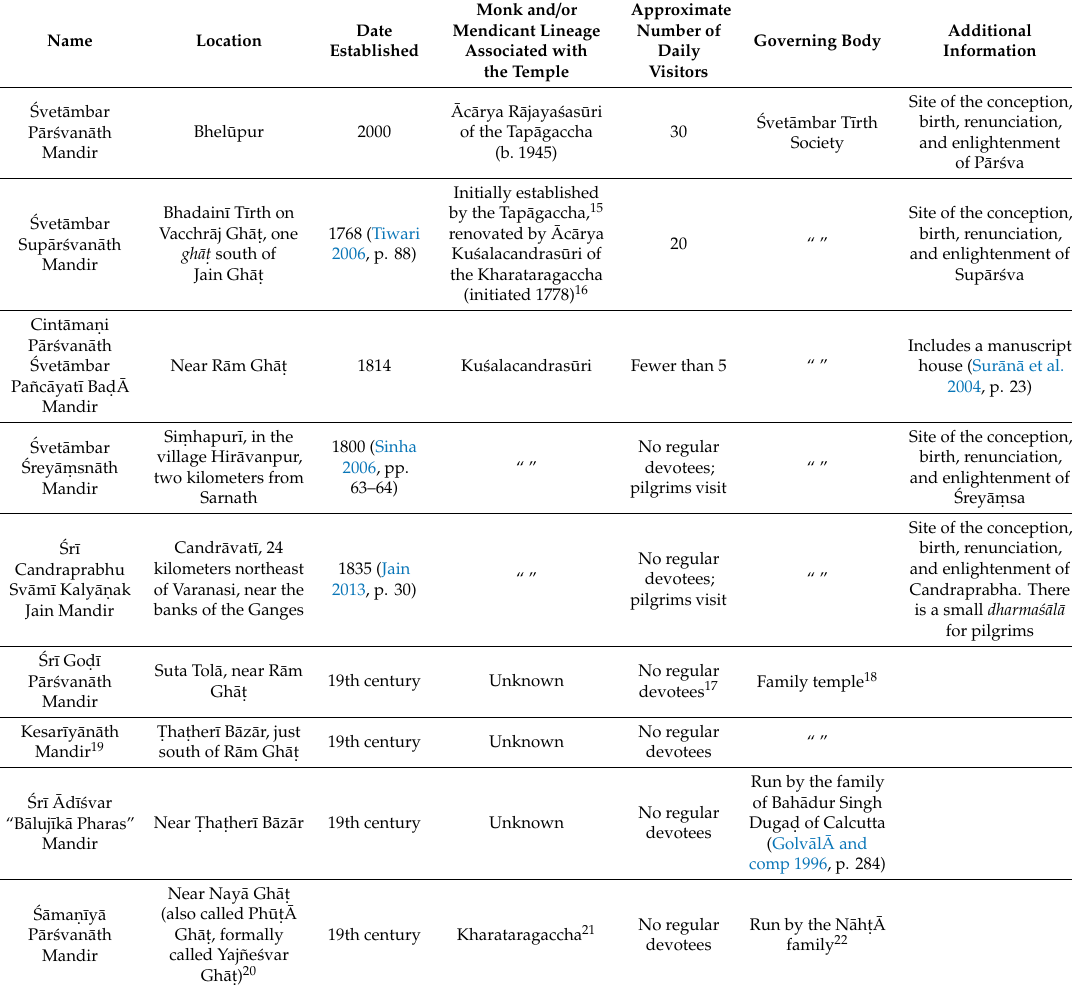
Table 3. ´Svet¯ambara temples in